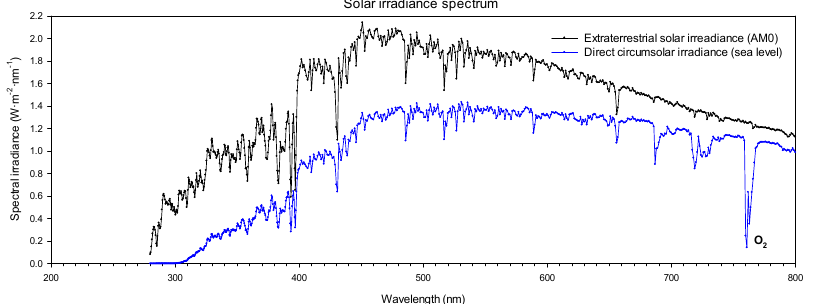
Figure 1. Extraterrestrial solar irradiance (outside the Earth’s atmosphere) and direct circumsolar irradiance spectral data [47] at sea level based on historical data from 1987 to 2003 within the spectral range of 200–800 nm. It shows the O 2 absorption band.